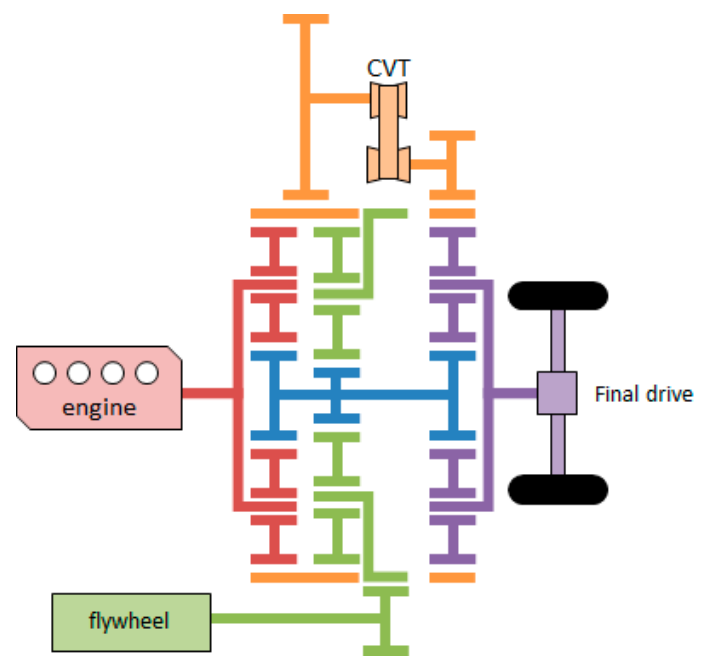
Figure 2. The PS-FHV configuration, consisting of three PGSs and one CVT.